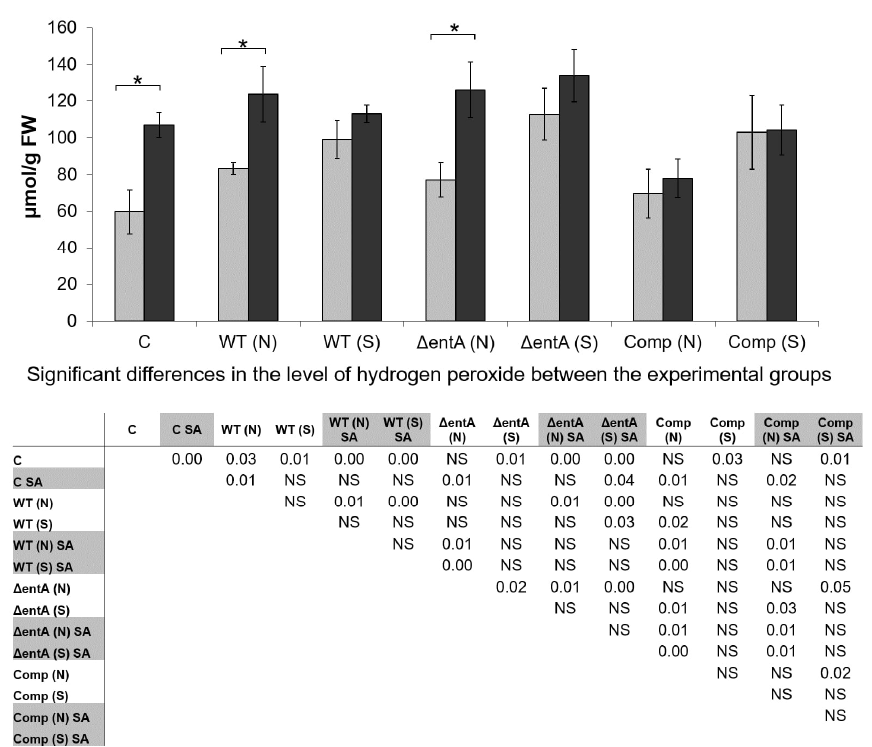
Figure 7. The level of hydrogen peroxide in non-primed (light grey) and salicylic acid-primed (dark grey) tobacco plants non-infected control (C) or infected with the wild type (WT), or ∆ entA mutant ( ∆ entA ), or ∆ entA complementation mutant (Comp) of Pectobacterium atrosepticum SCRI1043. Plants with symptoms (S) and with no symptoms (N) were analyzed differentially within all experimental groups (WT, Δ entA , Comp) of infected plants. The priming was performed one day before the inoculation. Hydrogen peroxide was determined one day post inoculation. The presented values are means ± SD of three biological replicates. Asterisks (*) show the significance of difference (Mann–Whitney two-sided test, p < 0.05) between non-primed and salicylic acid (SA)-primed plants within a single variant (C, WT, Δ entA , Comp). The table located under the diagram shows significant differences between all experimental groups; (SA)-primed variants are marked by grey in the table. NS—non-significant. FW—fresh weight.